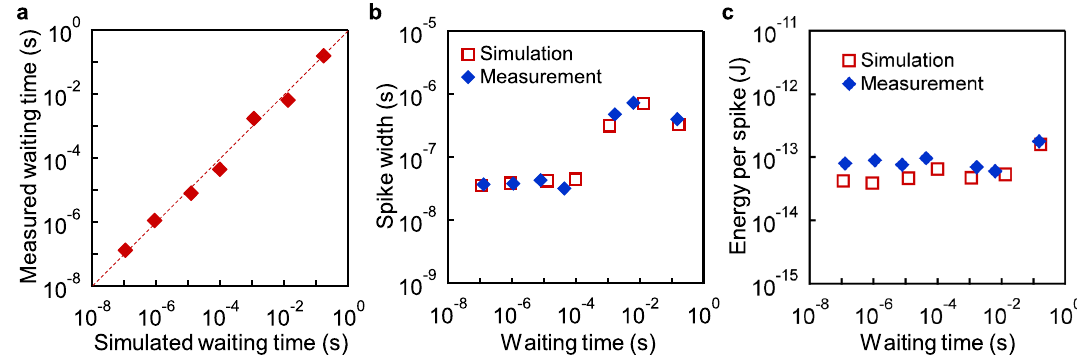
Figure 6. Comparison between experiments and simulations for spiking neuron circuits. ( a ) The experimentally measured waiting times of the fabricated spiking neuron circuits are plotted as a function of the simulating waiting times (post-layout simulation). The plot indicates the experimental results are approximately consistent with the simulation. ( b ) Experimentally obtained spike width and the simulated spike width as a function of the waiting time. ( c ) Experimentally obtained energy consumption per spike and the simulated energy consumption per spike as a function of the waiting time. In the experiment, the energy consumption was obtained by measuring I SOURCE in Fig. 5c with Keithley 6430.